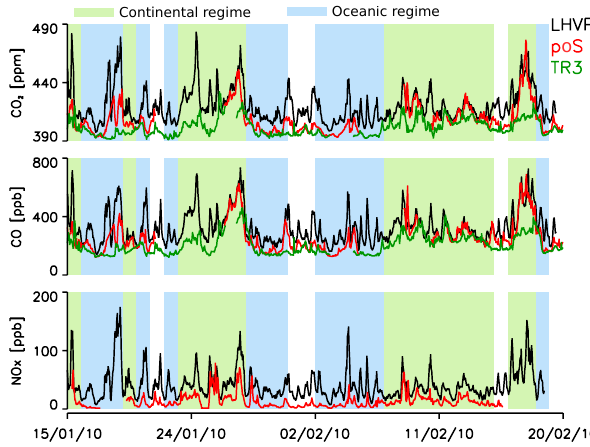
Fig. 2. The CO 2 , CO and NO x mole fractions at the LHVP, Plateau of Saclay (poS) and Trainou 180ma.g.l. (TR3). Periods during which the air masses originate from the west are highlighted in blue, and periods during which the air masses originate from the east are highlighted in green. No colour is used for the days without a clear air mass